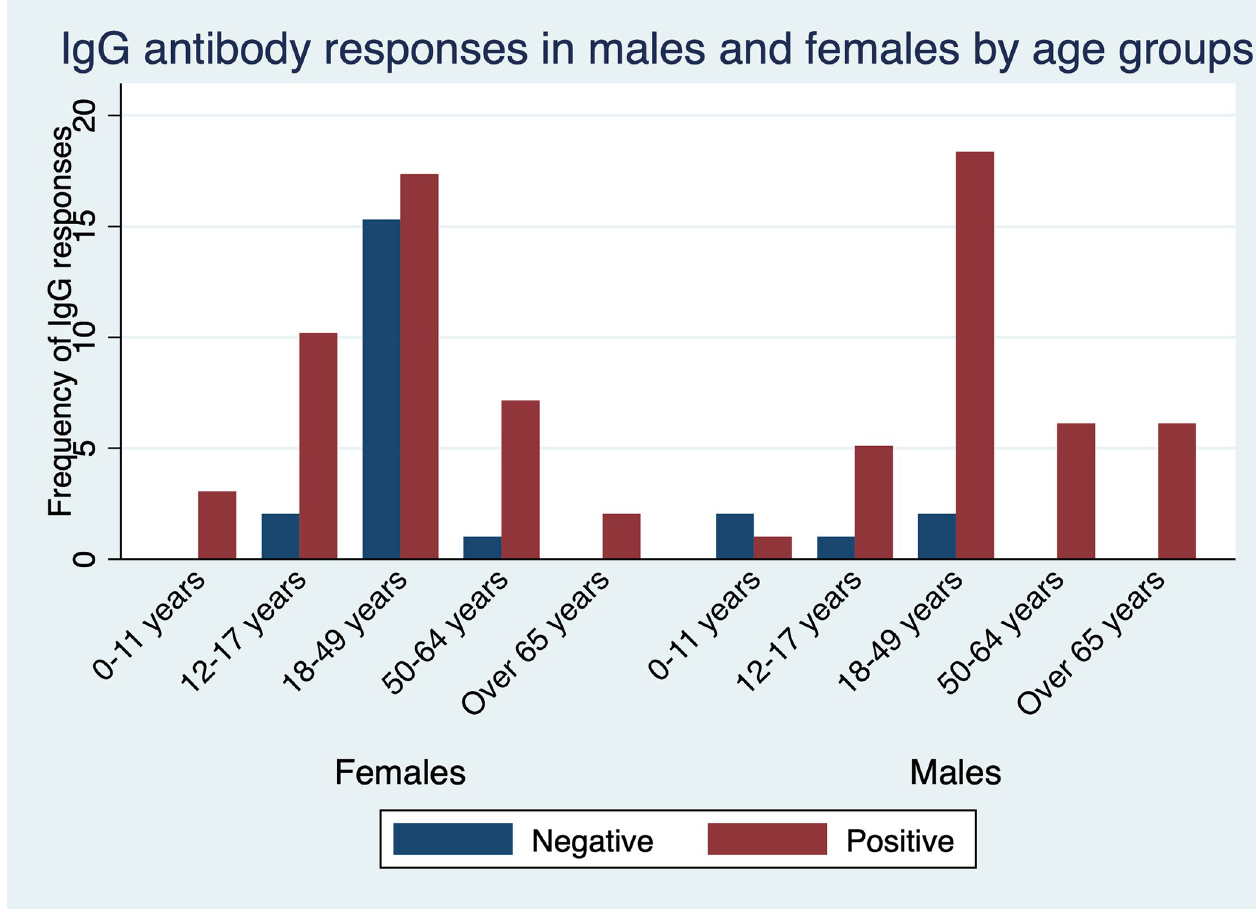
Fig 1. Seroprevalence of infection-induced SARS-CoV-2 IgG antibodies, by gender and age group—Kisumu and Siaya counties, Kenya, December 2021– March 2022.